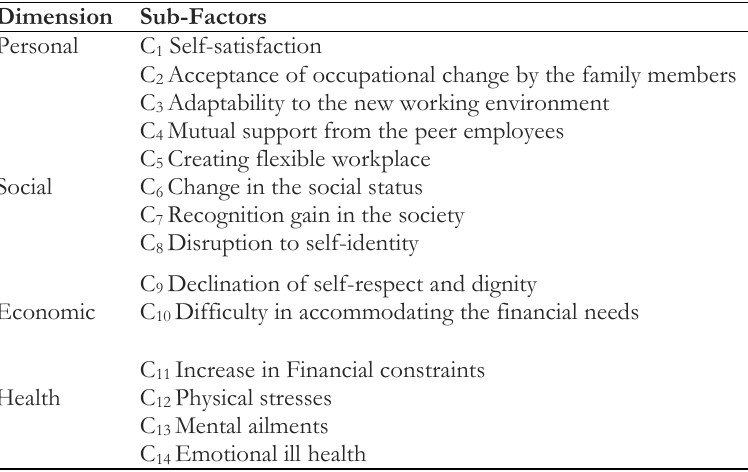
Table 1. The dimensions of personal, social, economic and health of rural